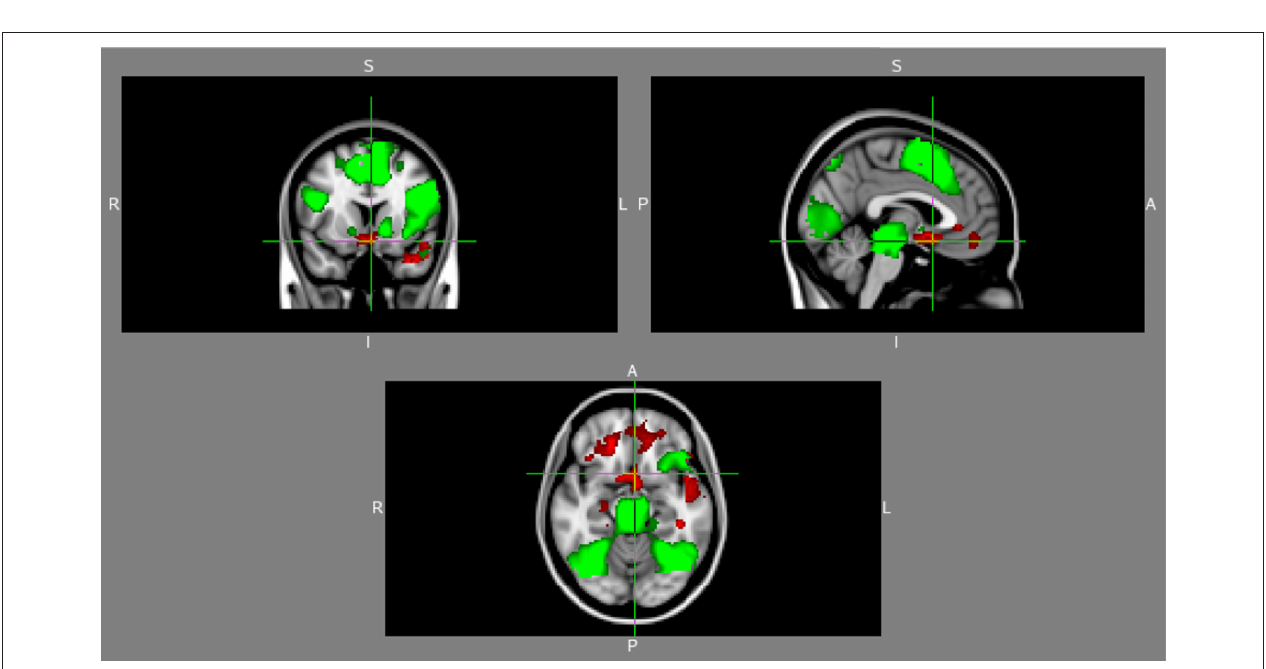
FIguRe 3 | Baseline (green) and added activations with oxytocin compared to placebo (red) in unmedicated depressed subjects during RMeT.